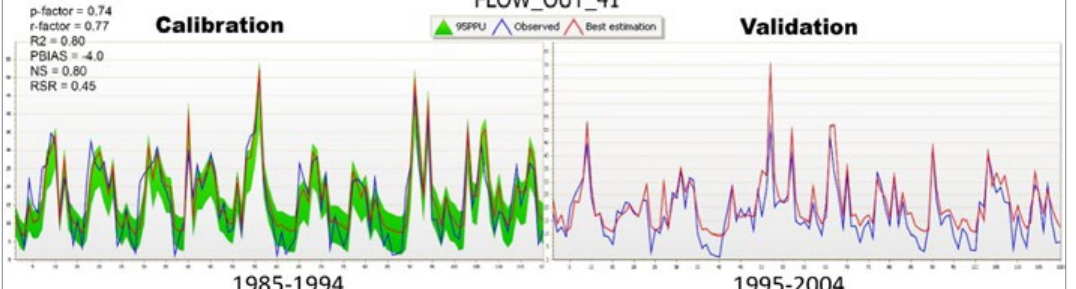
Fig. 3: Discharge calibration (1985-1994) and validation (1995-2004) of Muleta watershed